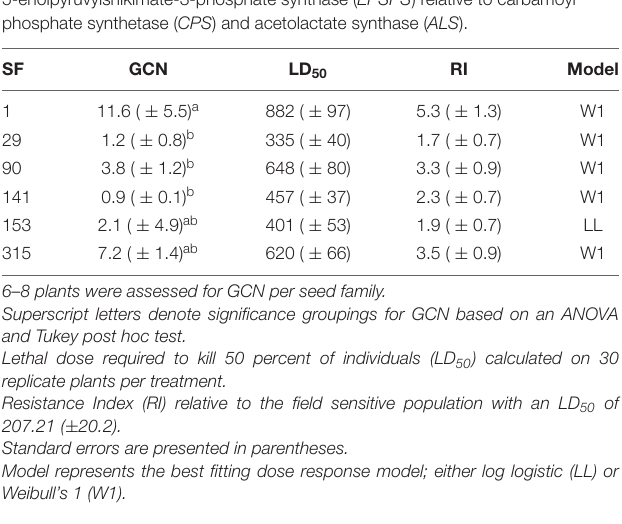
( Figure 4 ) (f-statistic = 22.99; df = 1; 4, p = 0.0087, R 2 = 0.85). The linear model estimates indicate that each gene copy increased glyphosate LD 50 by 44.3 g ai ha − 1 . Increased EPSPS gene copy number was associated with enhanced glyphosate resistance in the A. tuberculatus Renville population. Target site sequencing of the EPSPS gene confirmed the absence of non-synonymous mutations in the active site of resistant individuals (data not shown). Furthermore, there was no significant impairment of translocation of 14 C labeled glyphosate away from the site of application in resistant individuals ( Supplementary Figure 1 ).